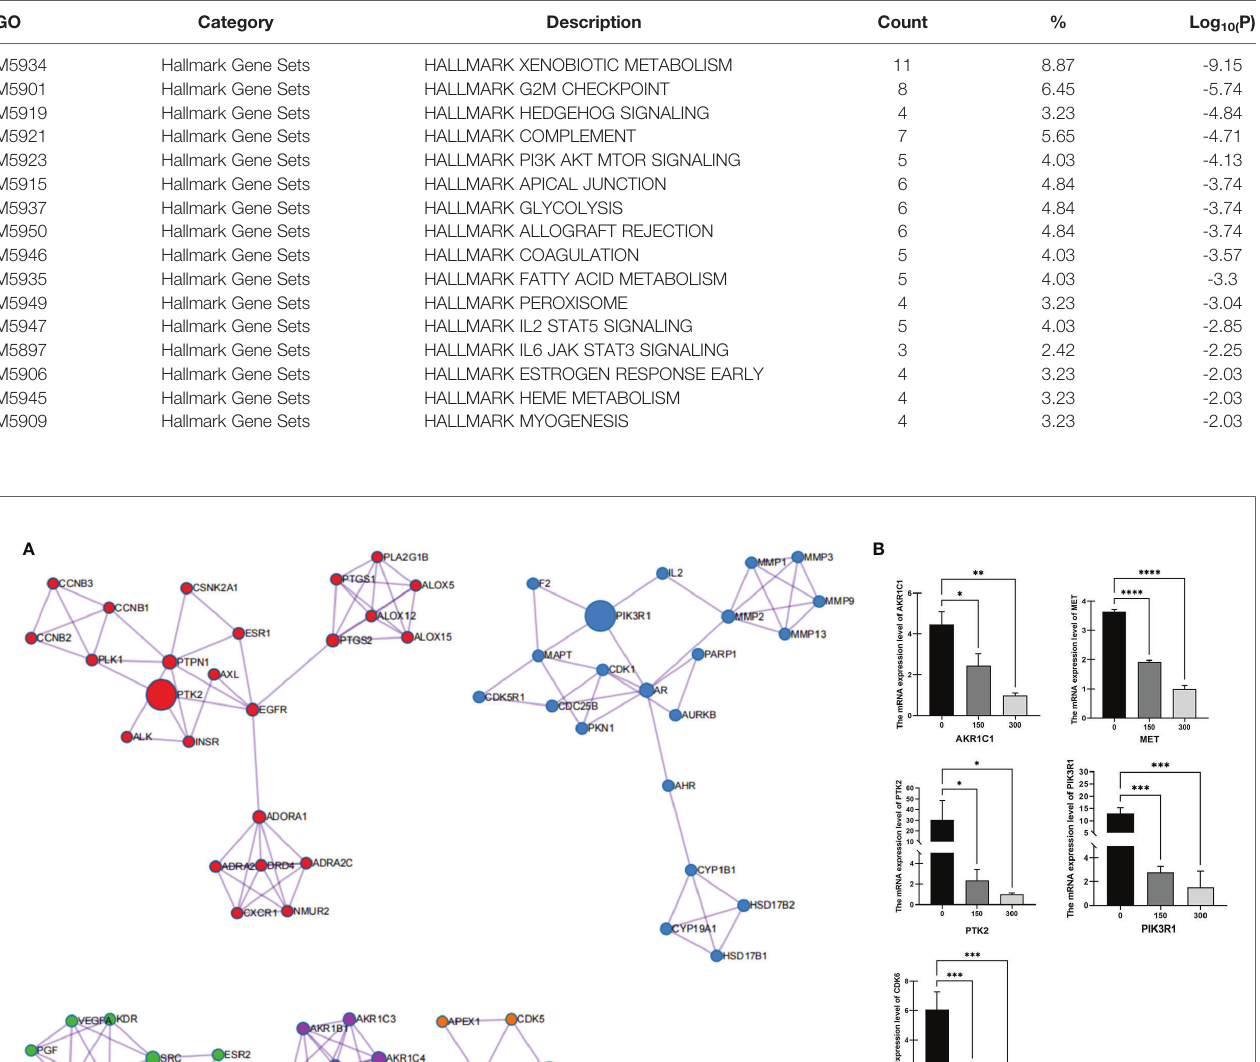
TABLE 5 | List of tops enriched Hallmark